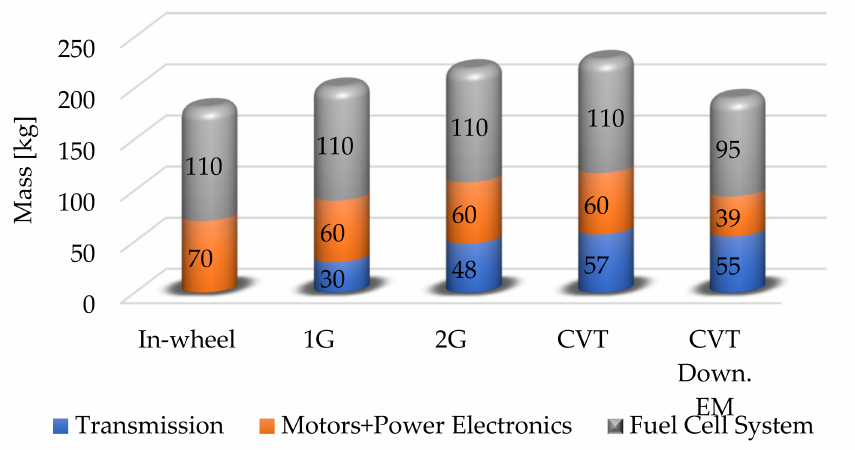
Figure 10. Comparison of the main subsystem